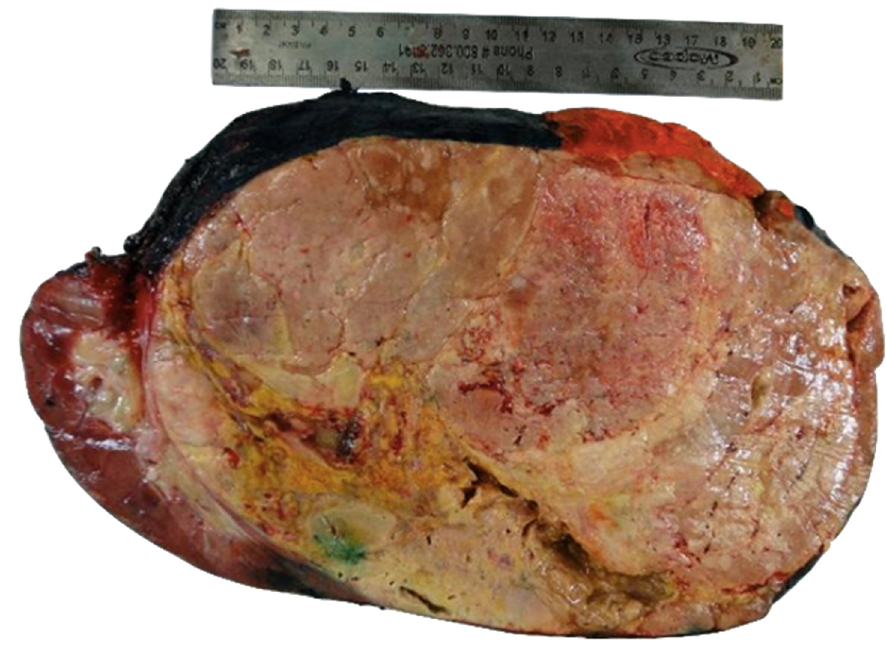
Figure 2. Gross image of tan-yellow mass with areas of hemorrhage and necrosis. Histologically, the lesion revealed solid sheets of the tumor with heterogeneous com- ponents and necrosis. The carcinoma component of the tumor consisted of polygonal cells with abundant eosinophilic granular cytoplasm and round nuclei with an open chromatin pattern (Figure 3). The sarcoma component was comprised of pleomorphic spindle cells, eosinophilic cytoplasm, identifiable mitosis, and dark, pleomorphic, hyperchromatic nuclei (Figure 4).